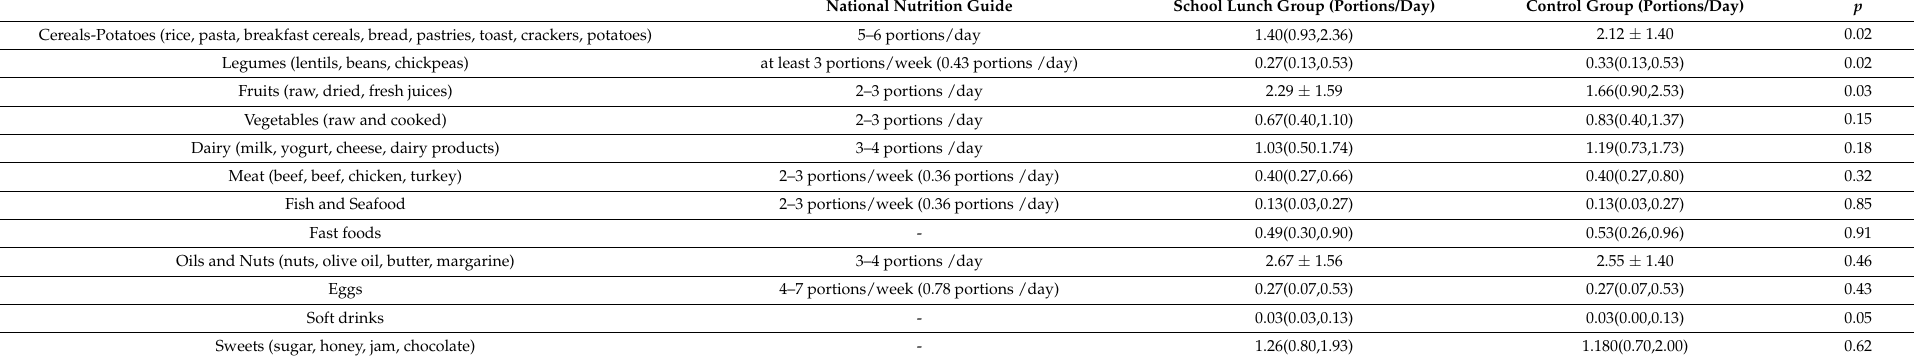
Table 4. Daily intake from food groups in the School Lunch and the Control group and in comparison with the National Nutrition Guide. National Nutrition Guide